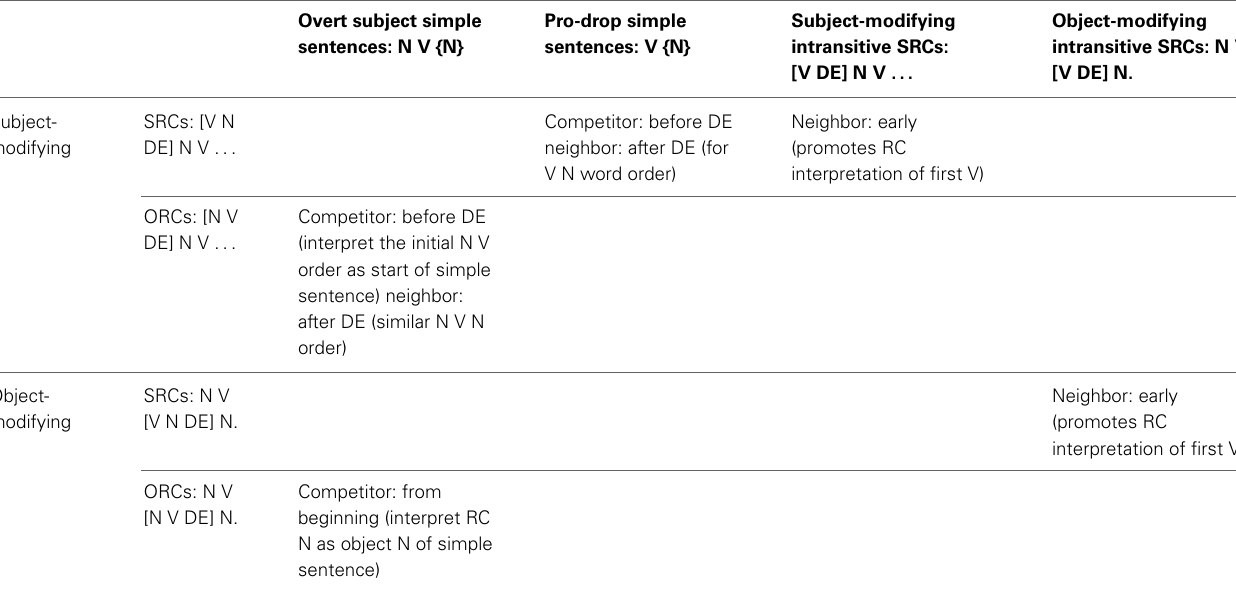
Table 1 | The competing and neighbor structures (listed on the top) we examined in the current study and the ambiguities and facilitation they created at different points for SRCs and ORCs at the two matrix positions (listed on the